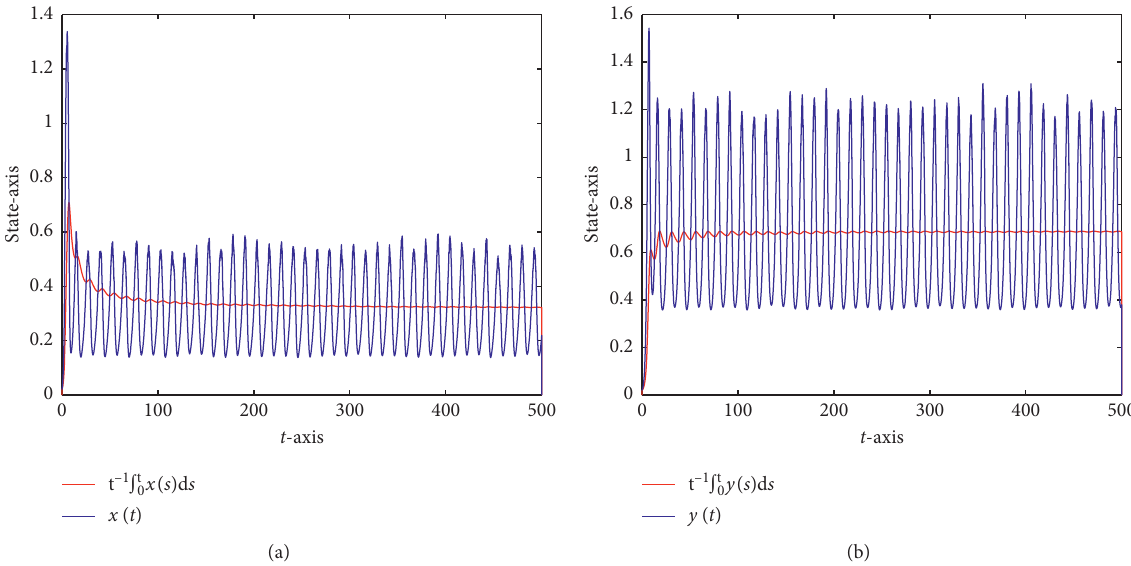
Figure 7: Permanence in the mean of (5) with n � 2 and x ( 0 ) � y ( 0 ) � 0 . 02. (a) The permanence in the mean of x . (b) The permanence in the mean of y